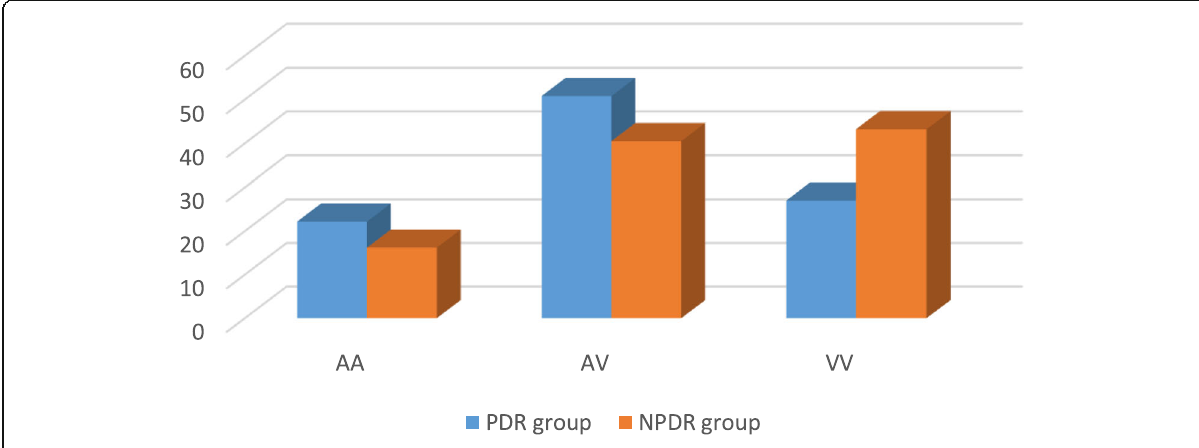
Fig. 2 Frequency distribution of different genotypes and alleles in peripheral DR and non-peripheral DR groups